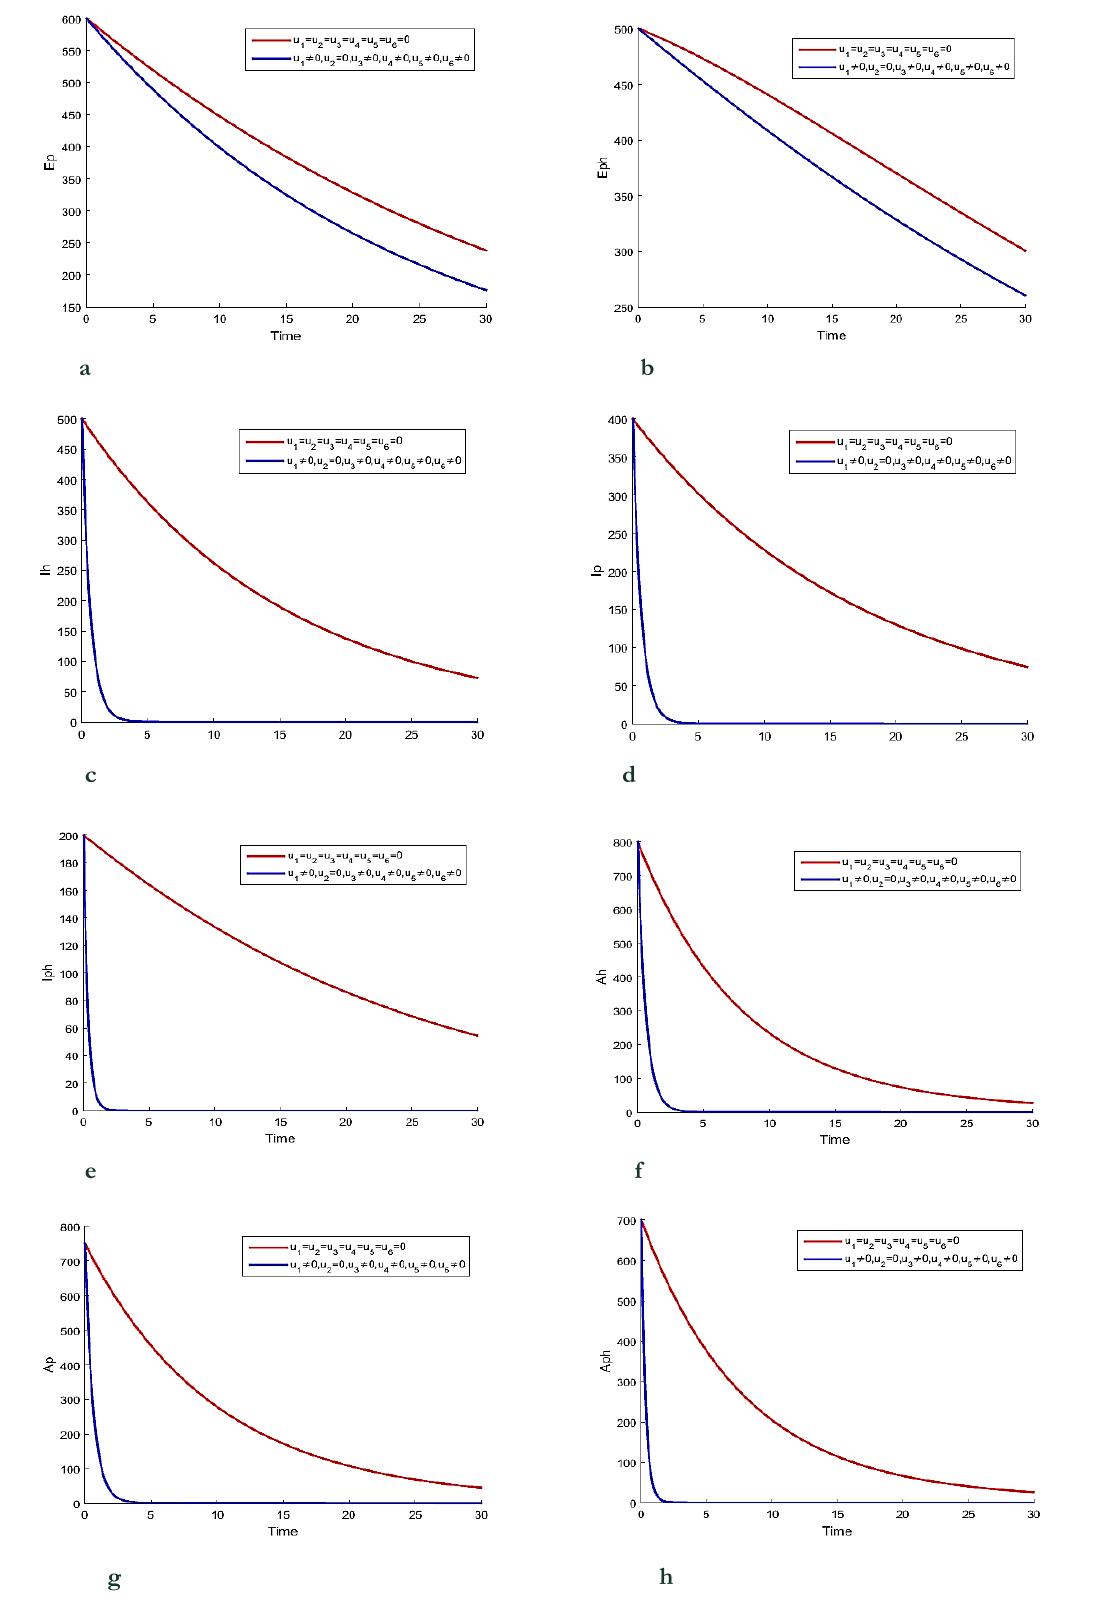
Fig. 2. Simulations showing optimal use of 𝐮